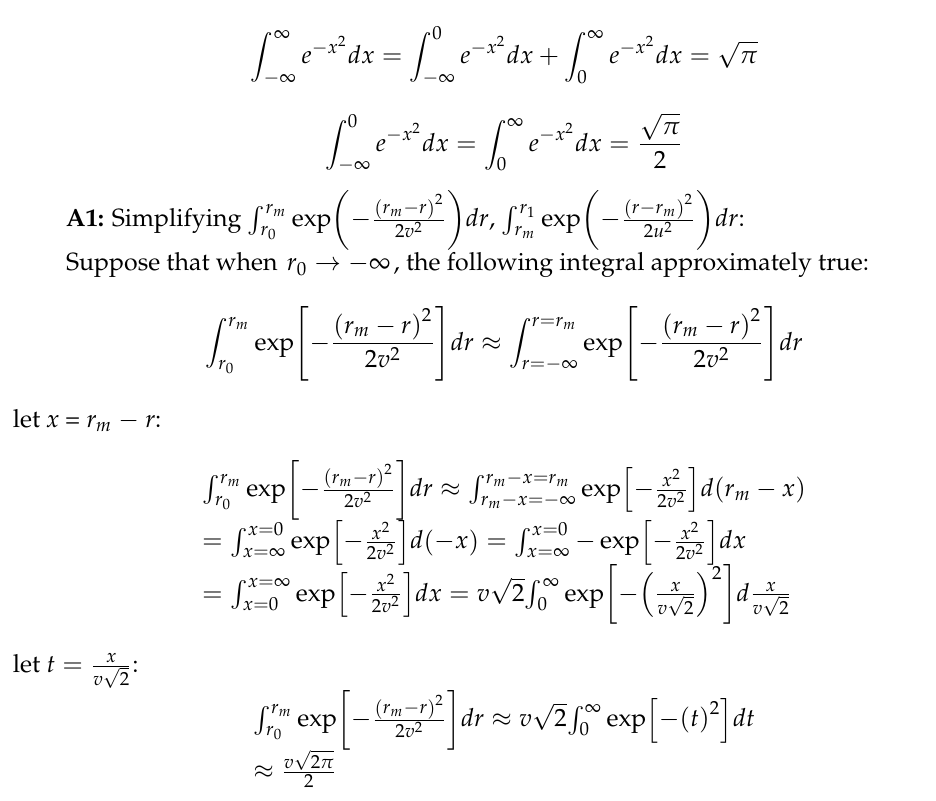
Figure A1. Schematic diagram of the exp(- x 2 ) function.